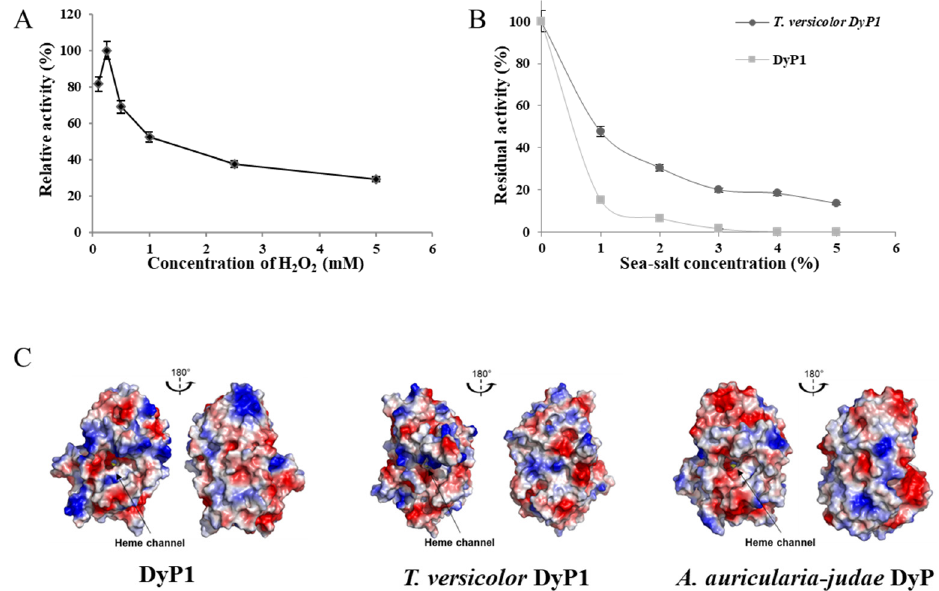
Figure 6. Effect of hydrogen peroxide and sea salt on DyP1 activity and surface charges of three different fungal DyPs. ( A ) The optimal concentration of hydrogen peroxide in standard conditions, using ABTS (5 mM) as a substrate. ( B ) Effect of sea salt addition on recombinant DyP1 and T. versicolor DyP ( Tv DyP1) as a control. Relative enzymatic activity recorded as in ( A ). Each data point (mean +/ − standard deviation) is the result of triplicate experiments. ( C ) Surface charge plots (negative and positive charges in red and blue, respectively) from homology models of DyP1 and Tv DyP1 (GenBank accession numbers 19415892) and from the experimental three-dimensional structure of Aau DyP from A. auricula - judae (PDB: 4W7J). The heme cofactor, deeply buried within the active site, is hardly visible (yellow spheres). Surface potentials were calculated using the vacuum electrostatics function of the PyMOL molecular graphics system (Schrödinger, New York, NY, USA).